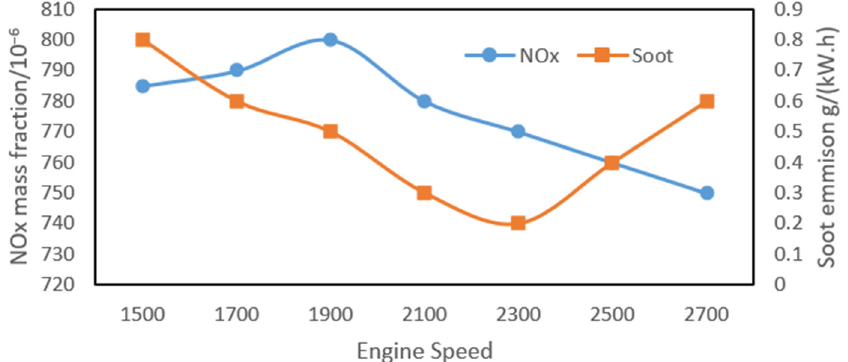
Figure 8. Pin bore deformation under the two schemes.